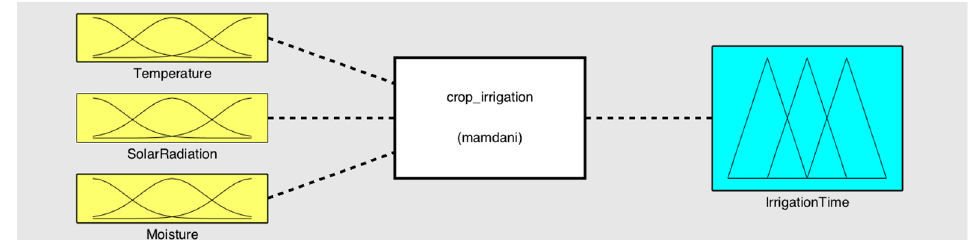
Figure 12. Inputs/output.